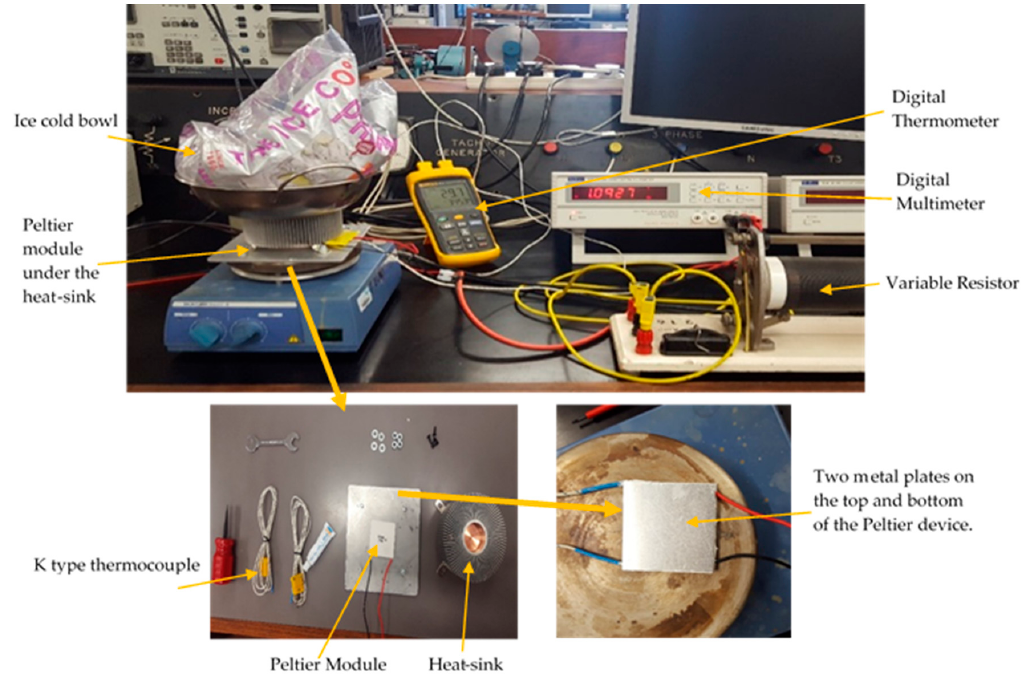
Figure 5. Photographs of the experimental setup for direct heat harvesting with Peltier TEG module connected with heat sink and ice-cooling to achieve larger temperature variance.